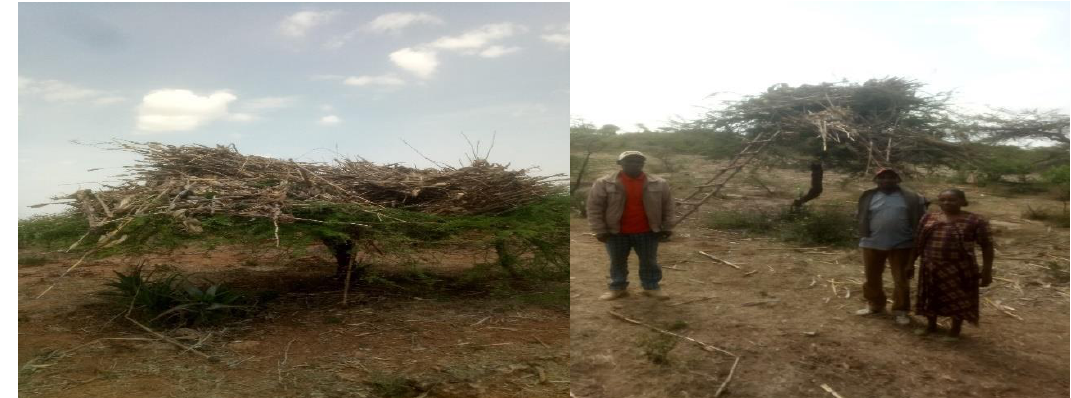
Figure 6. Endogenous knowledge-based adaptation practices at rural Sidama. Source: from Lokka Abaya district during field observation.